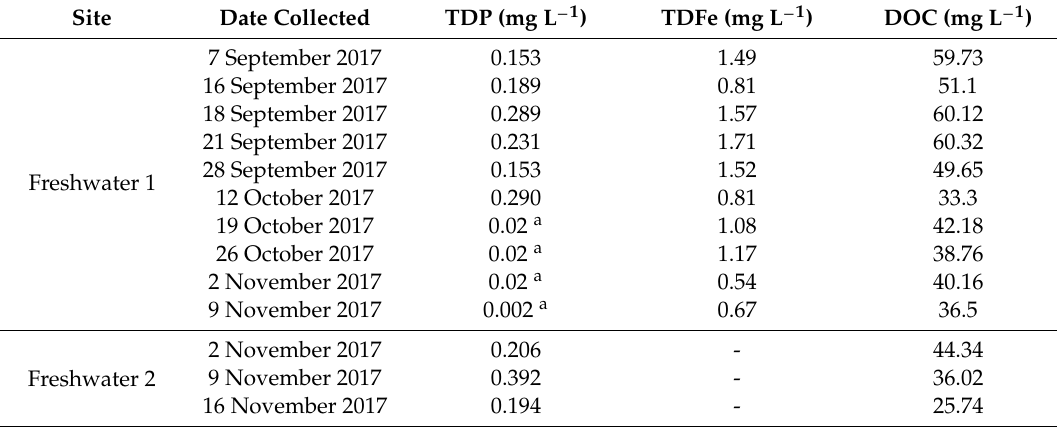
Table 2. Total dissolved phosphorus (TDP) and total dissolved iron (TDFe) concentrations from collected water samples that yielded values above the minimum limit of detection. Although other time points yielded dissolved organic carbon (DOC) values above the minimum detection limit, measurements from the specific dates where TDP and TDFe was measurable was included as a